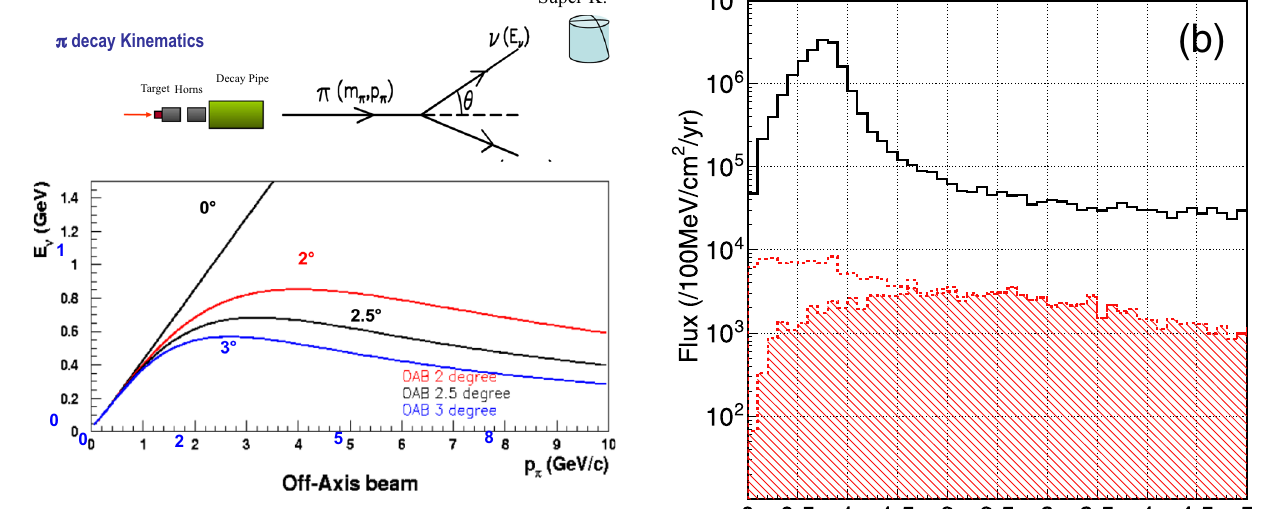
Fig. 41 A drawing of the off-axis beam kinematics (top) and the relation of neutrino energy and the off-axis angle (bottom). A quasi- monochromatic beam for a particular energy region is produced by tuning the beam angle